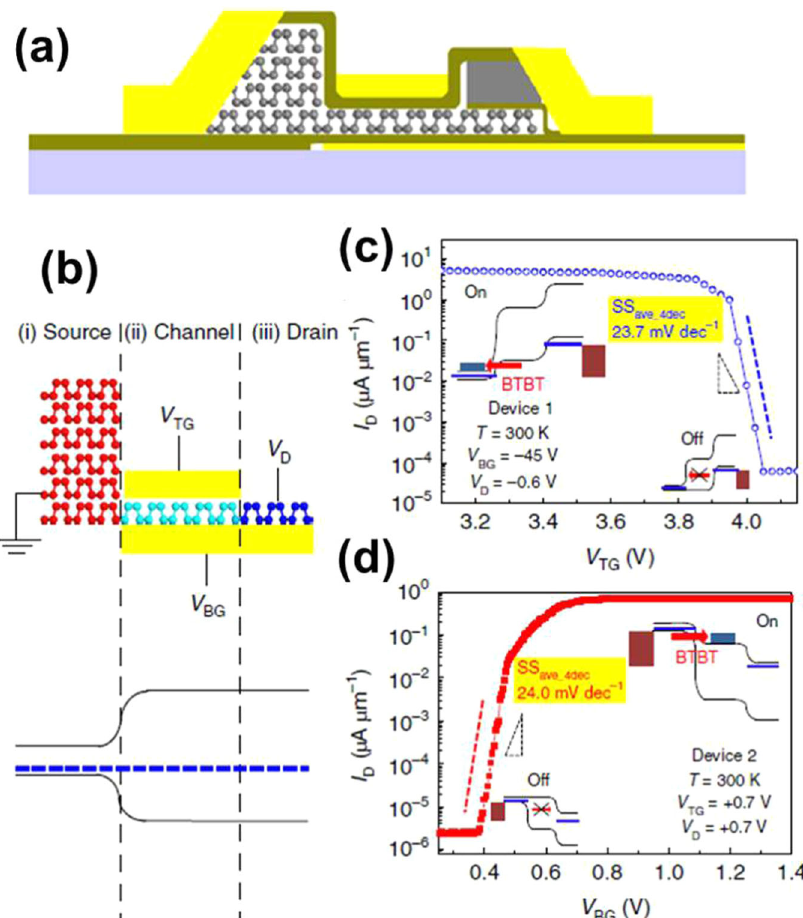
Fig. 26 Experimental Report on 2D Ph-TFET. a Device schematics, b material speci fi cations with equilibrium band alignments at the tunneling junction c n-type transfer characteristics, d p-type transfer characteristics of Bulk/1L-Ph, adapted with permission from 149 . Copyright (2019)